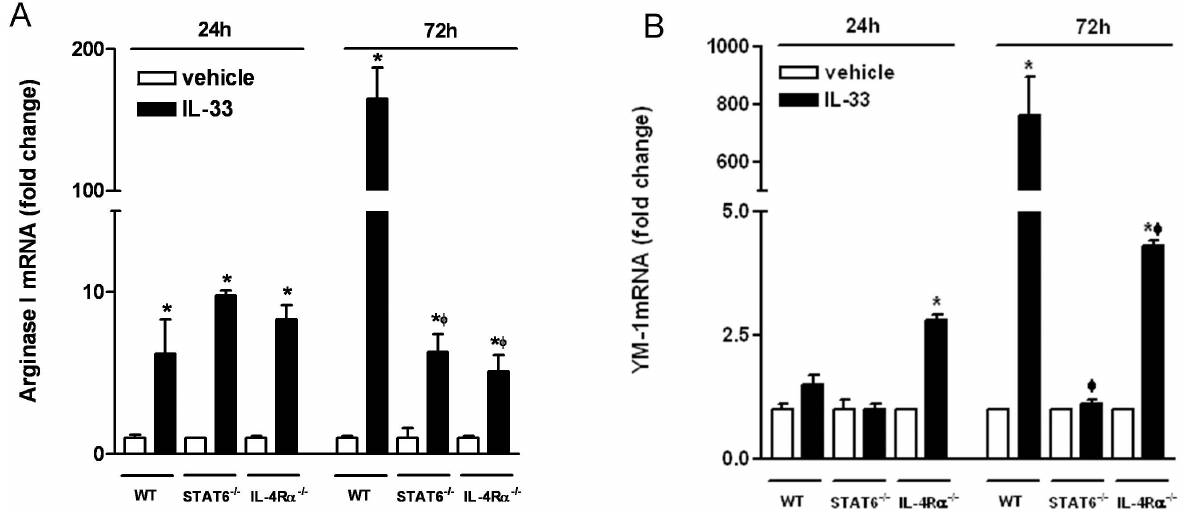
Figure 2. IL-33 induced alternative activation of macrophages invitro . BMDM from WT, STAT6 2 / 2 , or IL-4R a 2 / 2 mice were stimulated with IL-33 (24 and 72 hours), and analyzed for the expression of arginase I (A) or YM-1 (B) by qPCR (*p , 0.01 vs respective vehicle; w p , 0.001 vs WT-IL-33, one-way ANOVA followed by Neuman-Keuls test). Data shown in bar graphs are the mean 6 s.e.m and representative of two independent experiments with similar